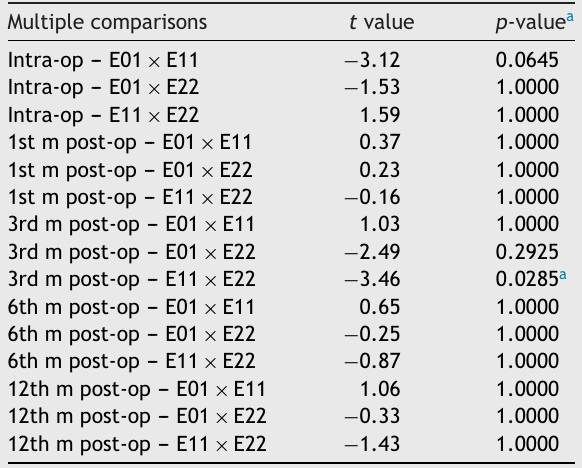
Multiple comparisons between the electrodes at each follow-up of the measurement of amplitude of N1-P1 waves ( (cid:2)